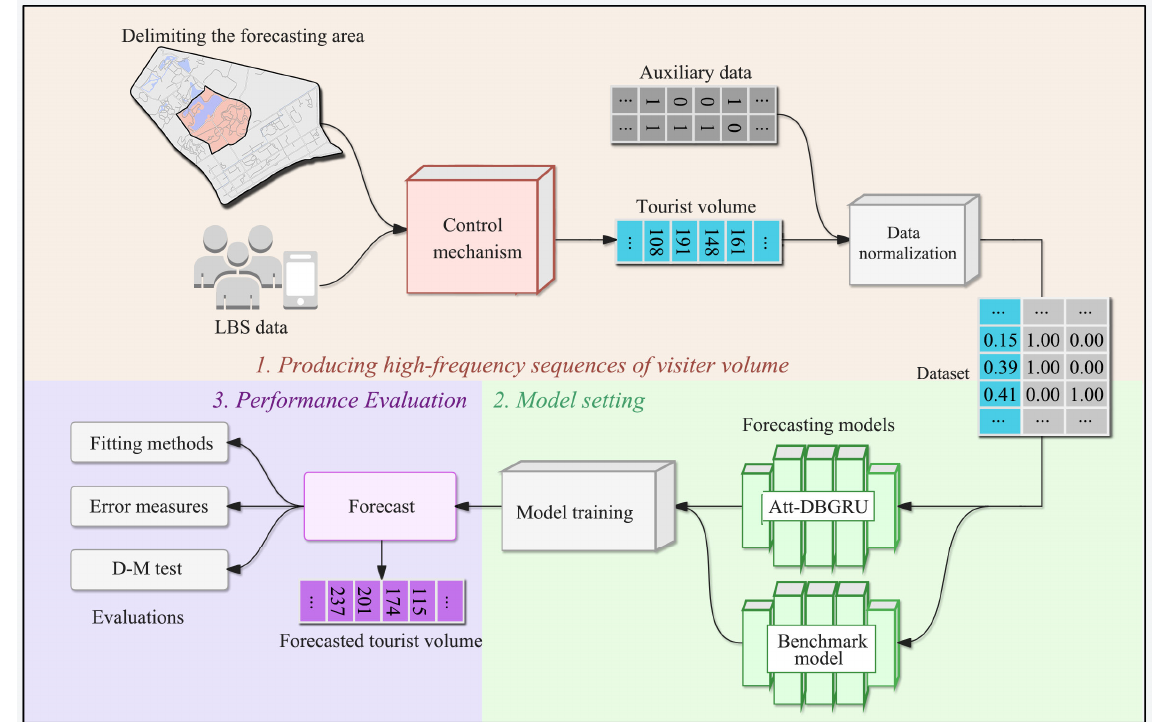
Figure 3. Illustration of the experimental procedures.